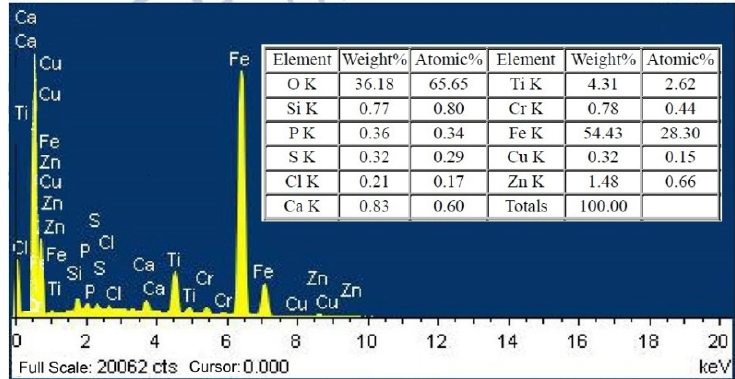
Figure 4. EDS coating analysis of the fracture.